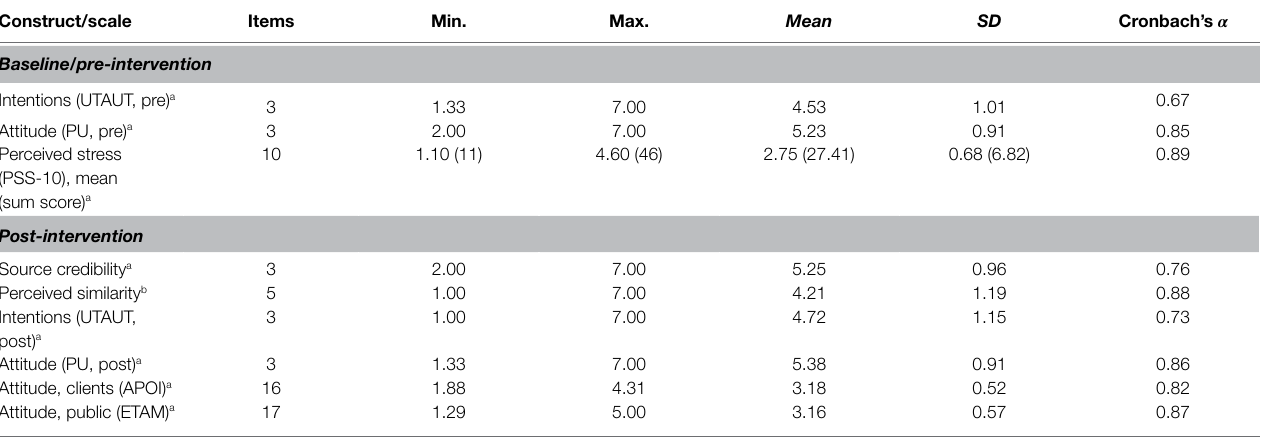
TABLE 1 | Constructs and psychometric data on the measured variables. Construct/scale Items